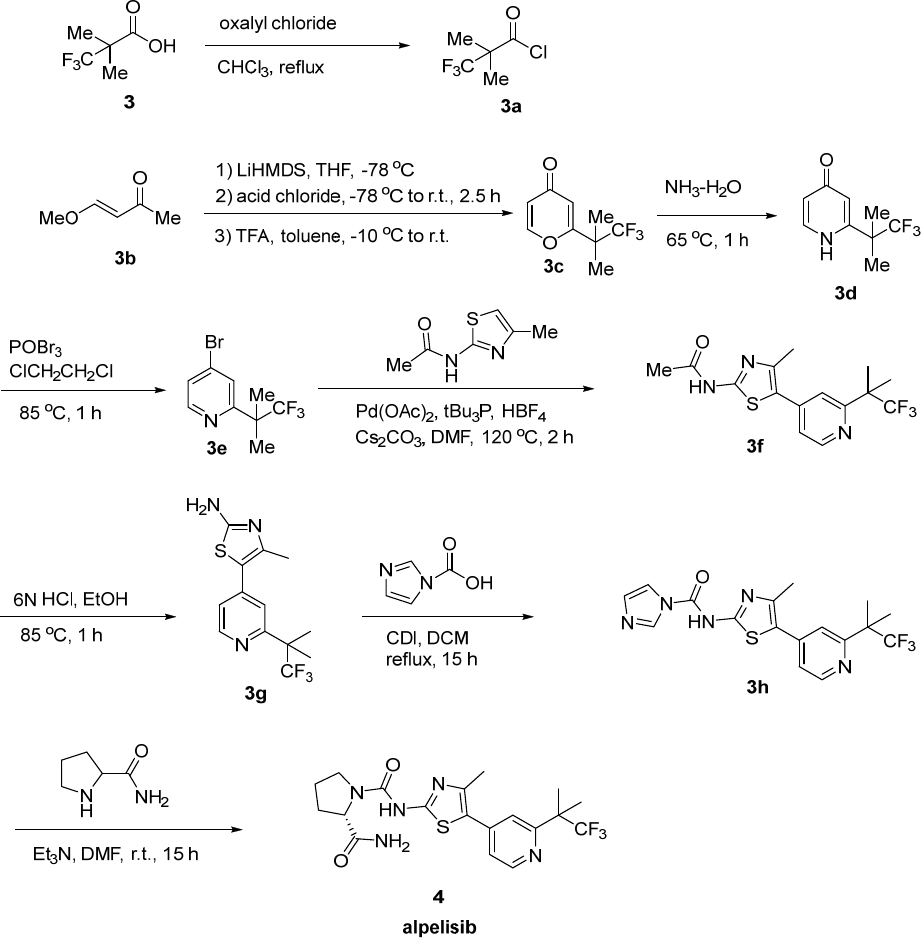
Figure 2. Synthesis and structure of alpelisib.